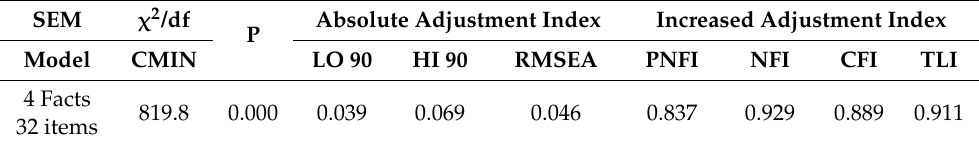
Table 1. Adjustment index of the model on the basis of the Religion, Interrelationship and Opinion in Children and Adolescents Questionnaire (RIOCAQ). SEM χ 2